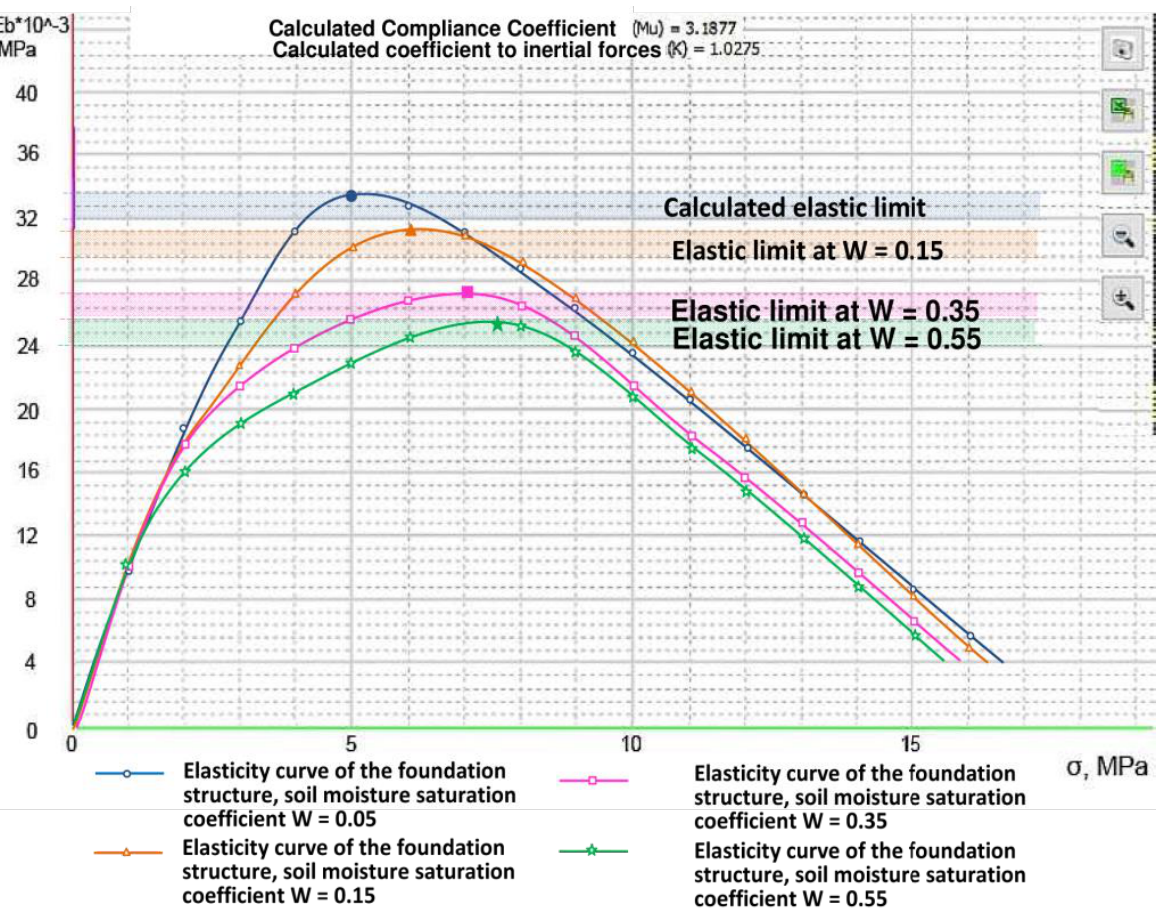
Figure 8. Dependences of the change in the elastic limit of the structure foundation materials on the arising mechanical stresses, taking into account the level of waterlogging of the soil base.